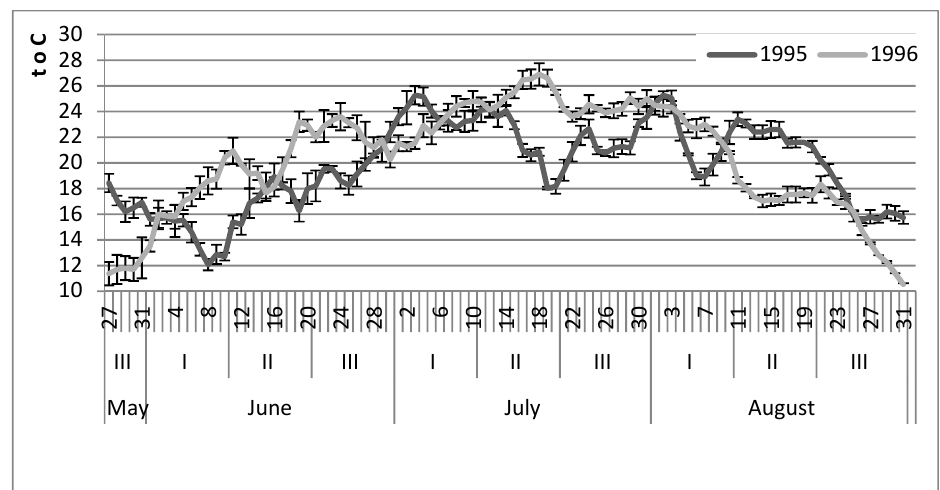
Figure 7. Seasonal dynamics of Bithynia troschelii abundance in the Kargat River estuary in 1995– 1996.